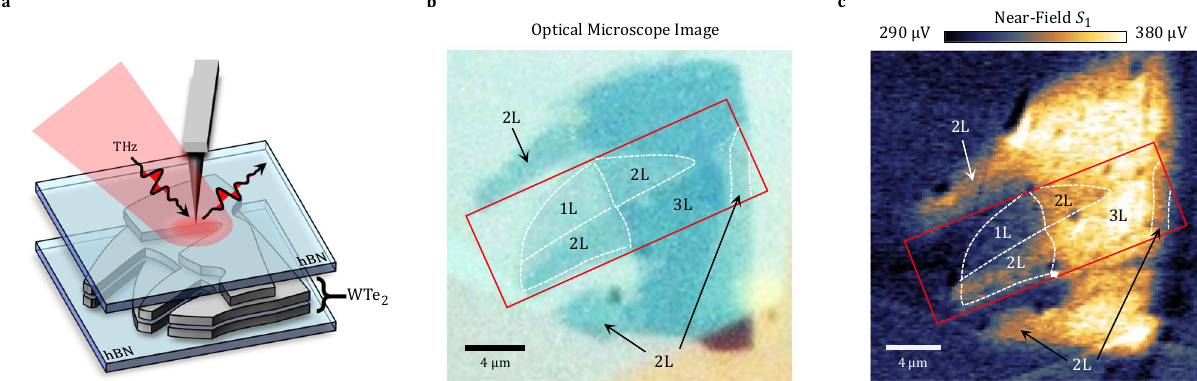
Fig. 1 Schematic of nano-THz experiments on multi-terraced crystals of WTe 2 . a Metallic AFM tip locally enhances the electric fi eld and enables THz coupling to materials at length scales much smaller than the THz wavelength. The size of the focused THz beam in the schematic is much smaller than the real focus. b Optical microscope image of the WTe 2 sample. Multi-terraced microcrystals of WTe 2 are encapsulated on top and bottom with hexagonal boron nitride (hBN) and reside on a SiO 2 /Si substrate. Optical inspection reveals 1L, 2L, and 3L regions. The red frame indicates the fi eld of view used for temperature dependent study in Fig. 2. We demarcate the boundaries of terraces labeled by layer number (1L, 2L, 3L) with white dashed lines. c THz near- fi eld signal S 1 at room temperature, showing much higher THz signal in the 3L region compared to 1L and